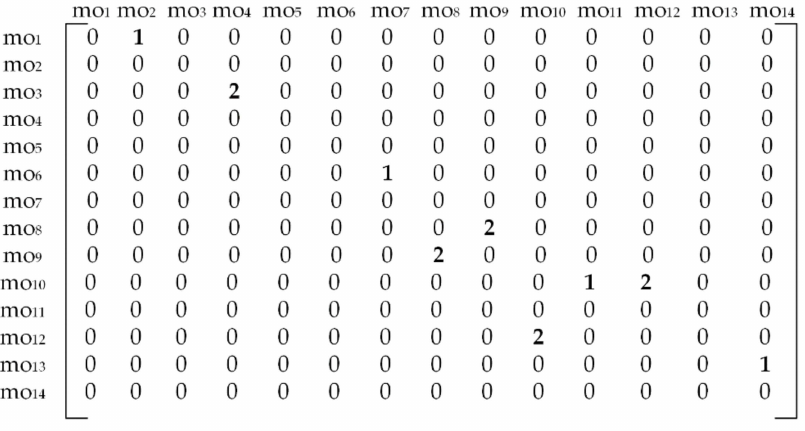
Figure 6. The adjacency matrix for the prismatic part